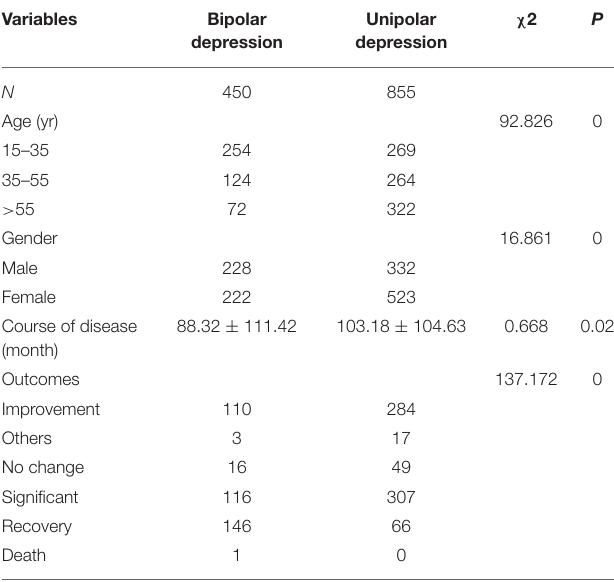
TABLE 1 | General characteristics of patients with bipolar depression and patients with unipolar depression.